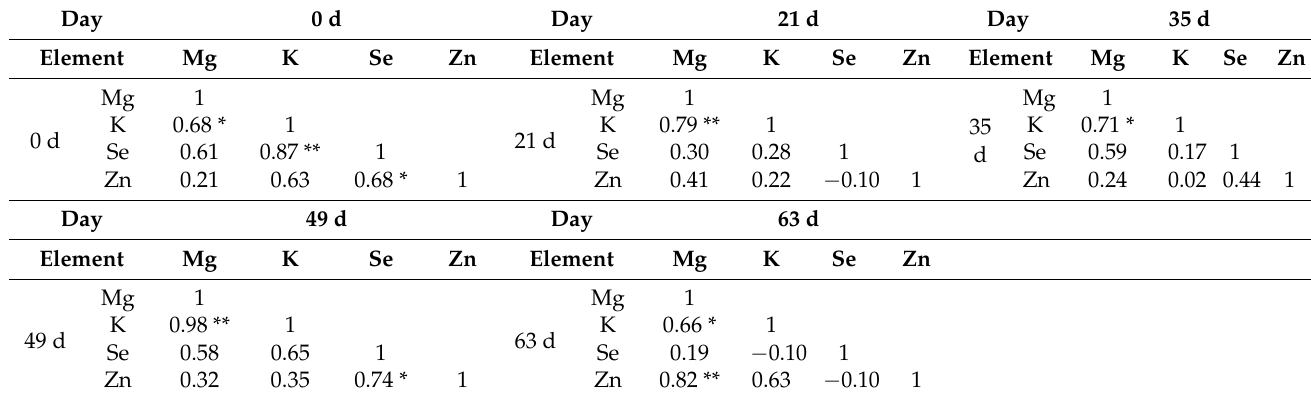
Table 6. Correlation between the depositions of mineral elements in the skin.